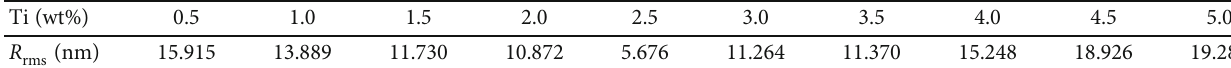
) deposition condition of ITiO fi lms. rms